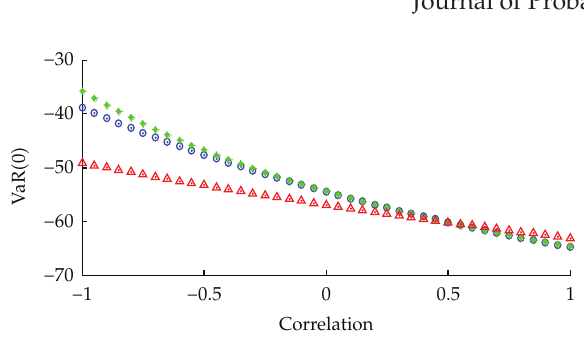
”represent (cid:0)